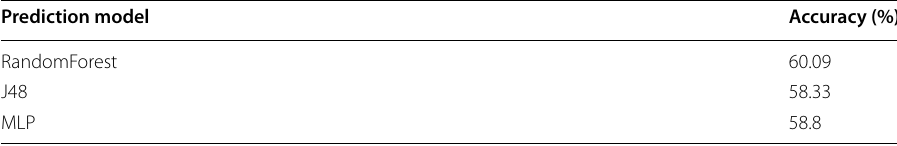
Table 18 Prediction model summary for topics prediction